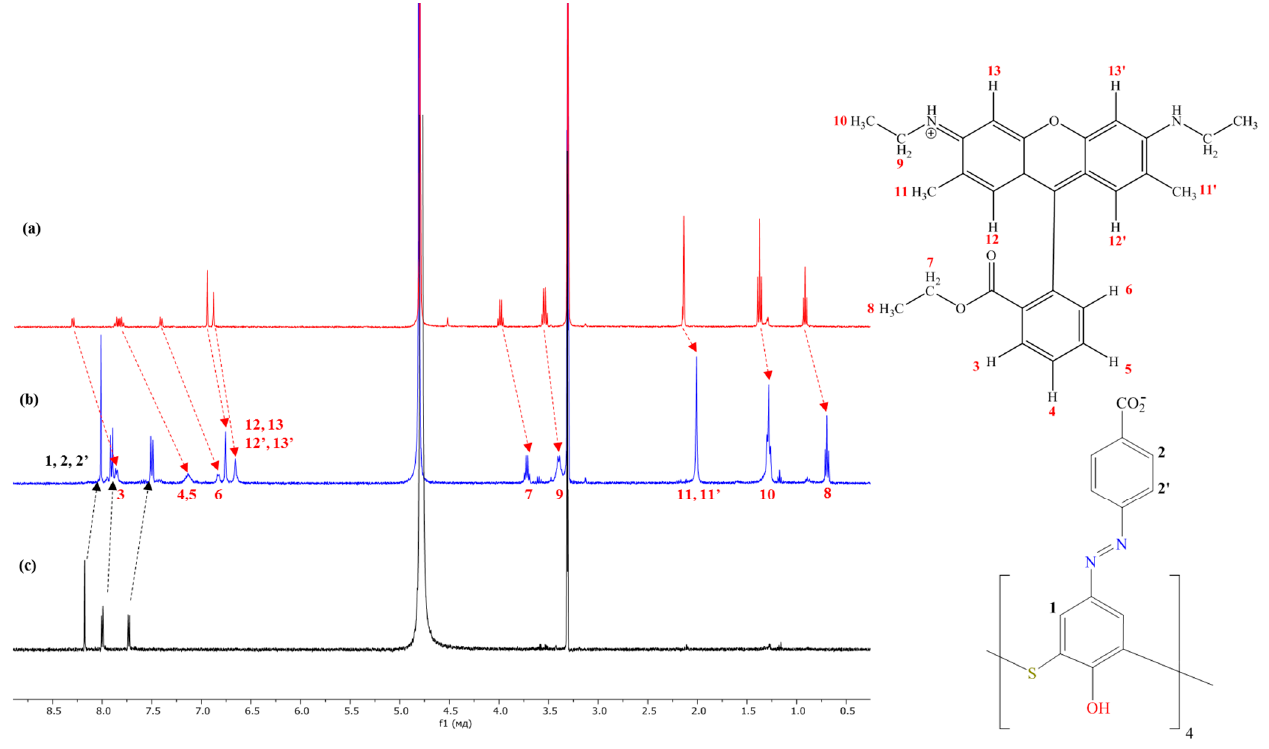
Figure 4. 1 H NMR spectra of 1.25 mM Rh6G ( a ), 2.5 mM thiacalixarene L ( c ), and their (0.5:1) mixture ◦ ( b ) in CD 3 OD-d 4 at 25 °C. ( b ) in CD 3 OD-d 4 at 25